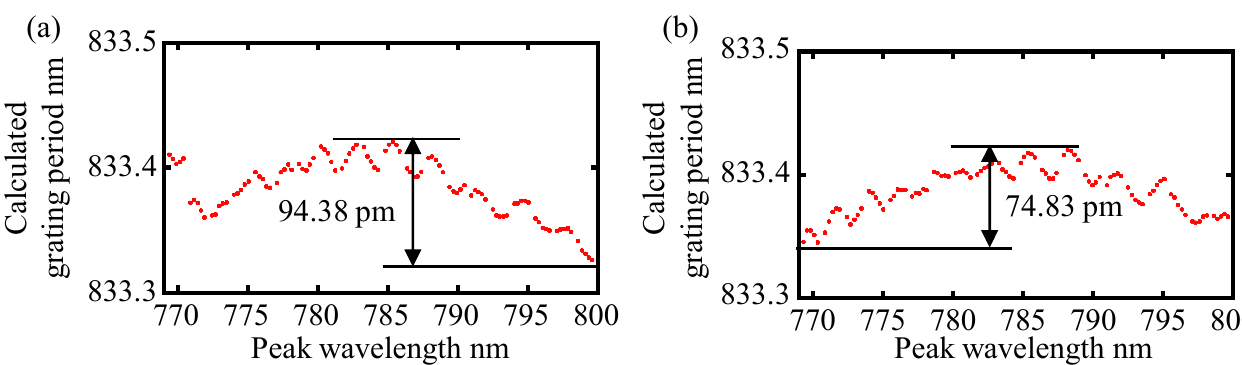
Figure 12. Compensation of the influence of the measurement laser beam spectrum. ( a ) Grating pitch calculated by using the spectra of the first-order diffracted beam I -1 ( λ i ); ( b ) Grating pitch calculated by using the normalized spectra I norm ( λ i ).